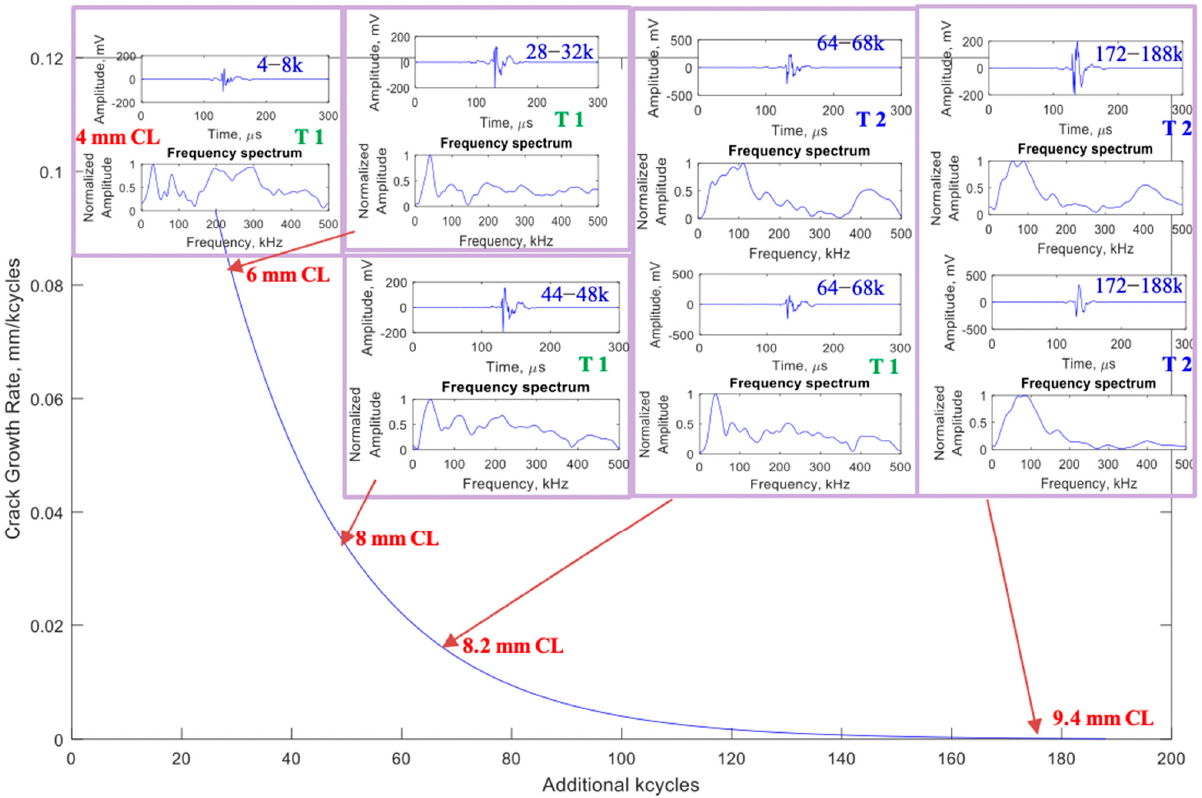
Figure 14. AE signal signatures recorded using PWAS–1 during additional fatigue cycles after crack growth. The fatigue crack growth rate plot is superimposed with representative AE signal signatures received during the cyclic fatigue AE experiment. Table 1. Time of arrival and sequence of arrival of T1 AE signals at various Sensors. PWAS-1 and S9225-1 are the closest to the crack. Hence, AE signals first arrive at PWAS-1 and S9225-1. PWAS 2 and S9225-2 are at 25 mm from the crack. Hence, AE signals arrive approximately at the same time at PWAS-2 and S9225-2. This analysis confirms that AE signals are originating from the crack. Time of Arrival (TOA), µs (Relative) Sequence of Arrival PWAS 1 32 1